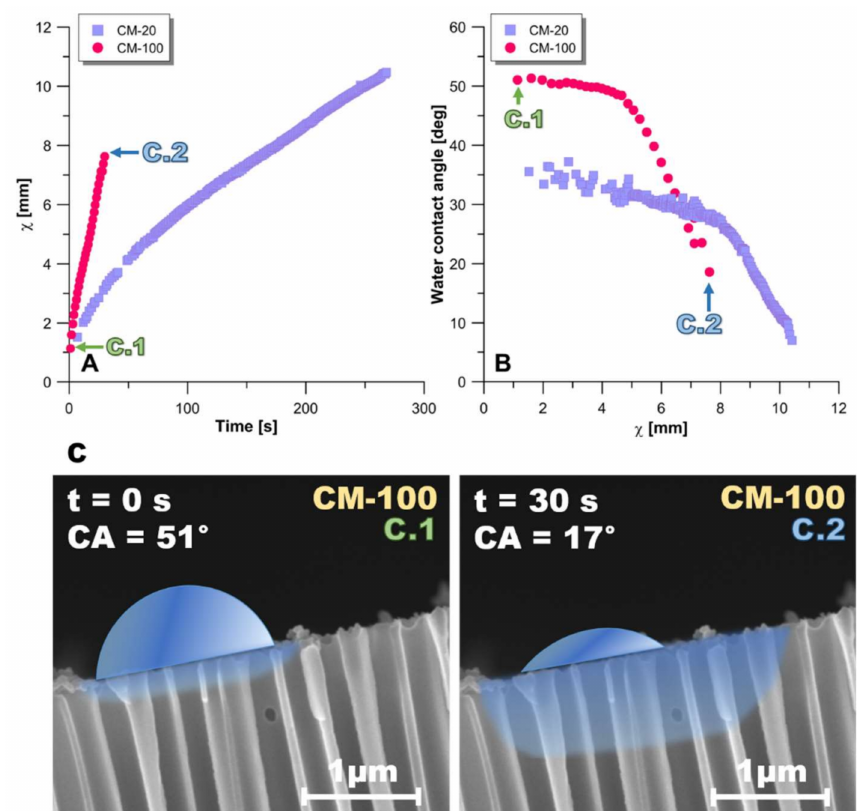
Figure 2. Behavior of water drop deposited on pristine membranes CM-20 and CM-100: ( A ) evolution of χ parameter as a function of time; ( B ) the correlation between χ and the apparent water contact angle (CA); ( C ) visualization of water drop behavior directly after deposition ( C.1 ) and after 30 s ( C.2